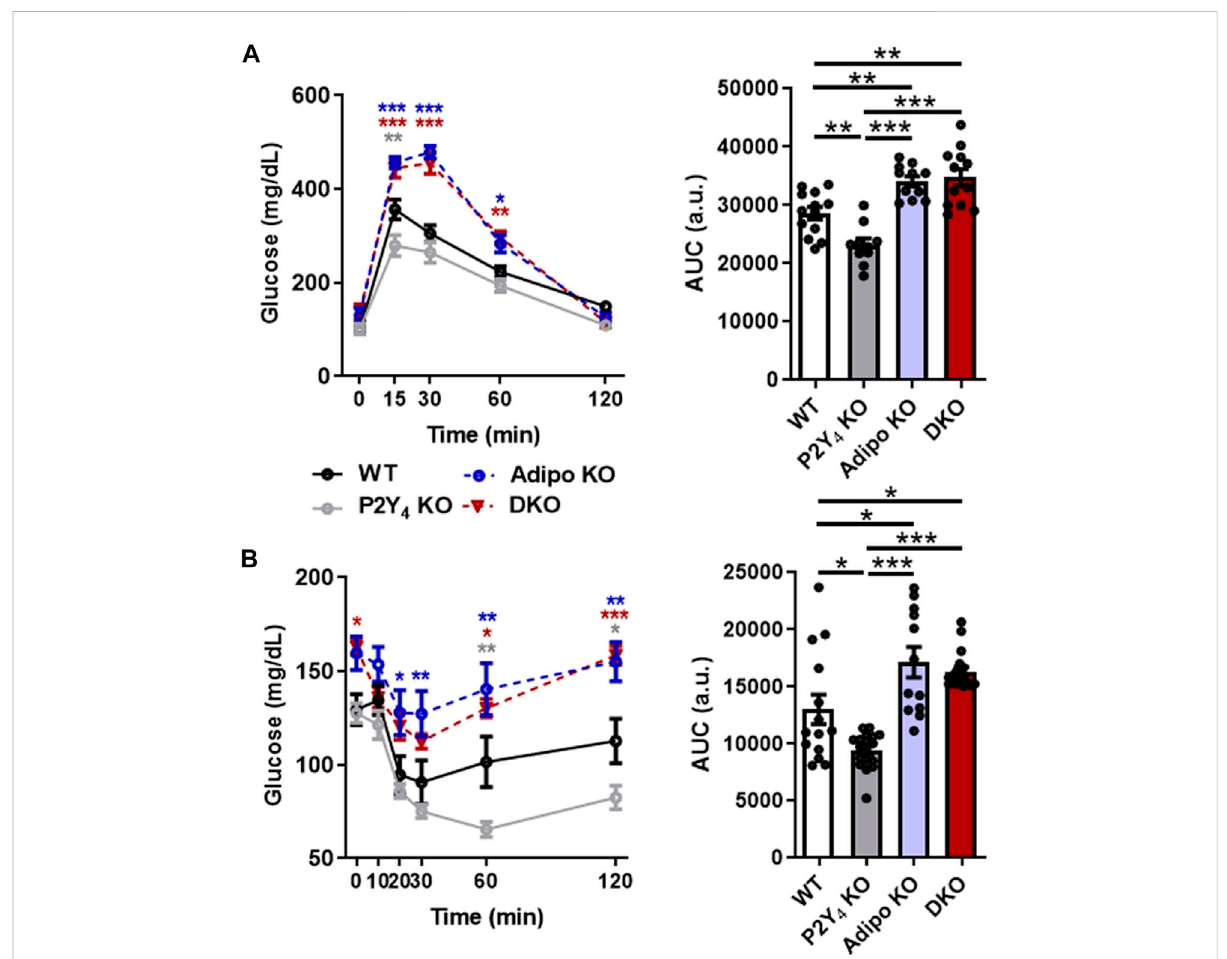
FIGURE 4 LossofmouseP2Y 4 receptorimprovesglucose metabolism. (A) Glucosetolerance testinP2Y 4 KOmice. After6 h-fasting,glucose(2 g/kg)was intraperitoneally injected, and blood glucose levels were monitored in WT, P2Y 4 KO, adiponectin KO (AdipoKO) and P2Y 4 /adiponectin double-KO (DKO) mice ( n = 12 – 14). Statistical differences from the control values (WT mice) are shown. (B) Insulin tolerance test in P2Y 4 KO mice. After 6 h- fasting, insulin (0.5 U/kg) was intraperitoneally injected, and blood glucose levels were monitored ( n = 8 – 14). The area under the curve was quanti fi ed both in panels (A,B) with GraphPad Prism software (a.u., arbitrary unit). The data represent the means ± SEM. * p < 0.05; ** p < 0.01; *** p < 0.001.Valuesfor individualtime points (left graph)and areaunder thecurve(right graph) wereanalyzed usingrespectively one-way ANOVAtestand two-way ANOVA test with Bonferroni post hoc